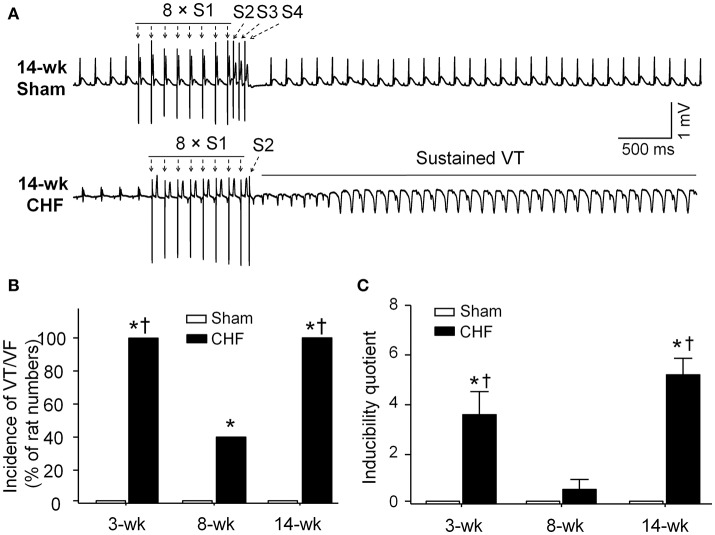
Inducibility of ventricular tachyarrhythmia evoked by programed electrical stimulation (PES) in anesthetized sham and CHF rats. (A) Representative ECG recordings showing nonoccurrence of PES-evoked ventricular arrhythmias in sham rat, and induction of VT evoked by PES in 14-week CHF rat. (B,C) Incidence and inducibility quotient of ventricular arrhythmias in 3, 8, and 14-week sham and CHF rats. Data are mean ± SEM; n = 5 rats in each group. *P < 0.05 vs. age-matched sham rats; †p < 0.05 vs. 8-week CHF rats.